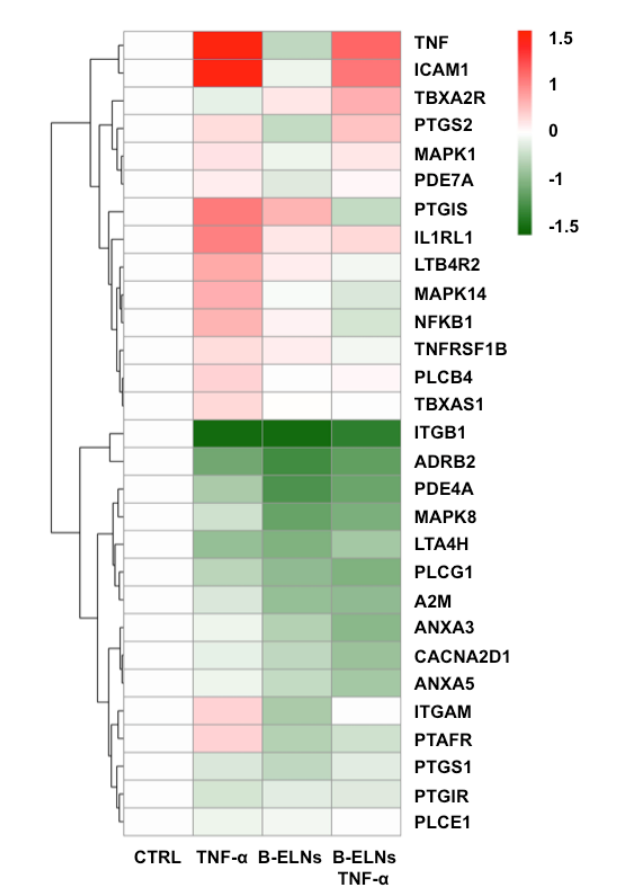
Figure 6. Heat map of the 29 di ff erential expressed genes in EA.hy926 cells exposed to TNF- α (20 ng / mL) for 2 h and pretreated or not with B-ELNs (20 µ g / mL) for 3 h. Data are represented as log fold change between − 1.5 and + 1.5 versus